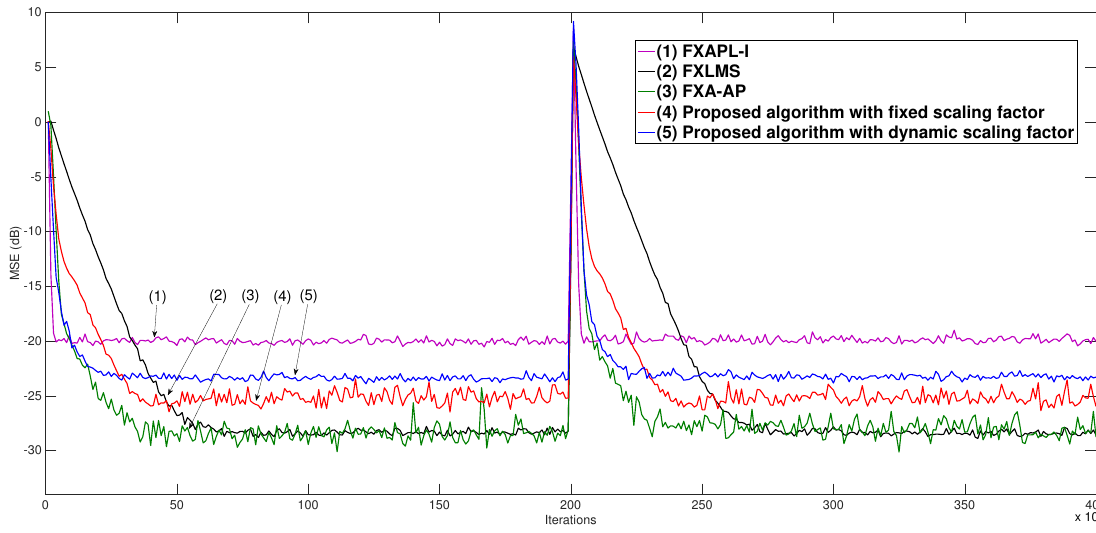
Figure 3. Learning curves for the FXAPL-I algorithm, the FXLMS algorithm, the FXA-AP algorithm and the proposed algorithm for a multitonal input in a single-channel system. Table 8. Total number of multiplications and additions of the FXAPL-I, FXLMS, FXA-AP and the proposed algorithms for a single-channel ANC system using a multitonal noise input. Algorithm